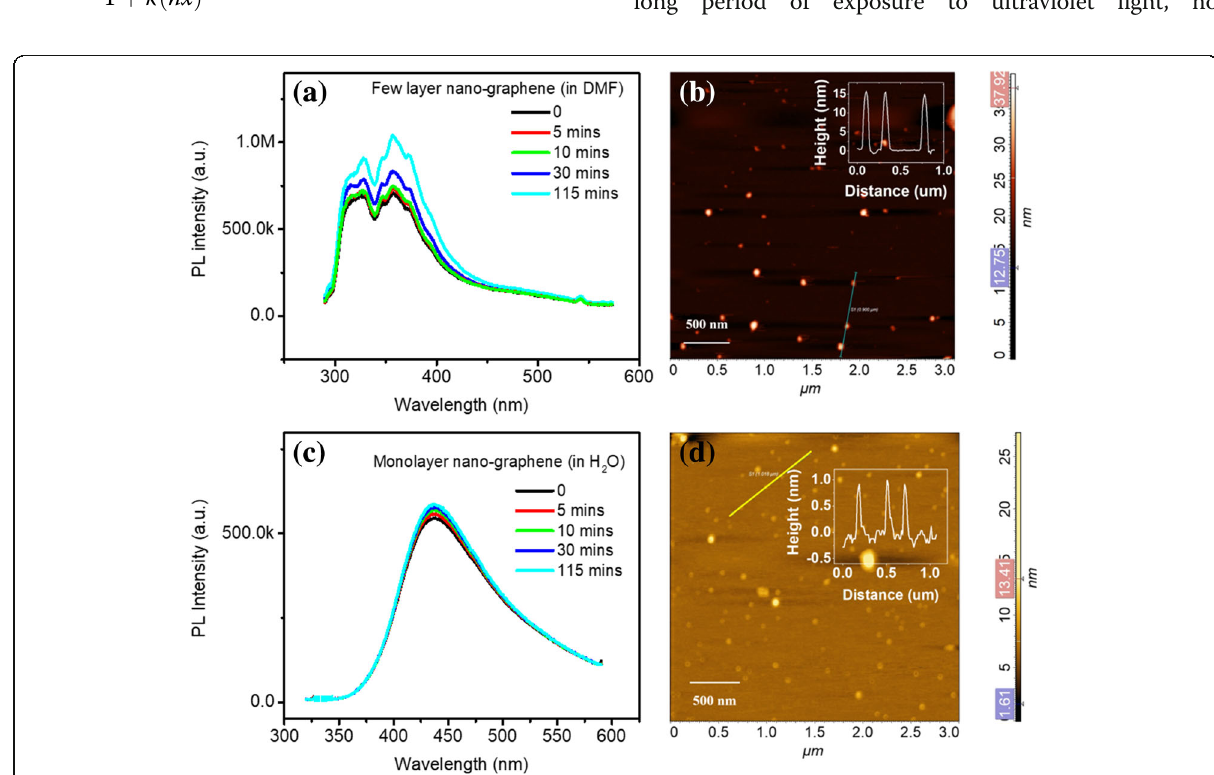
Fig. 9 PL and AFM image of nano-graphene in DMF ( a , b ) and H 2 O ( c , d